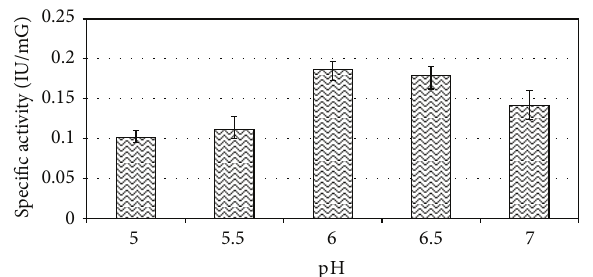
Figure 3: Effect of pH on specific ADI activity of E. faecium sp. GR7. Results are expressed as the mean ± S.D ( 𝑛 = 3 ), 𝑃 value < 0.05.